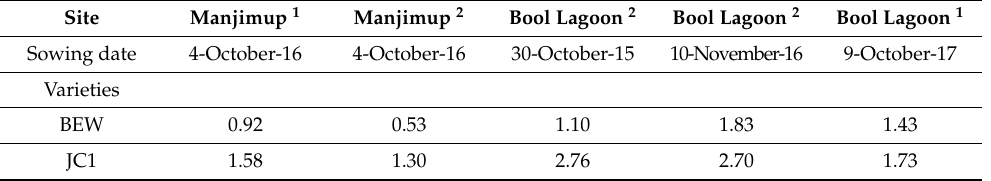
Table 10. Seed yield (t/ha) of quinoa varieties and germplasm at irrigated and/or rain-fed trial sites with a warm-summer Mediterranean